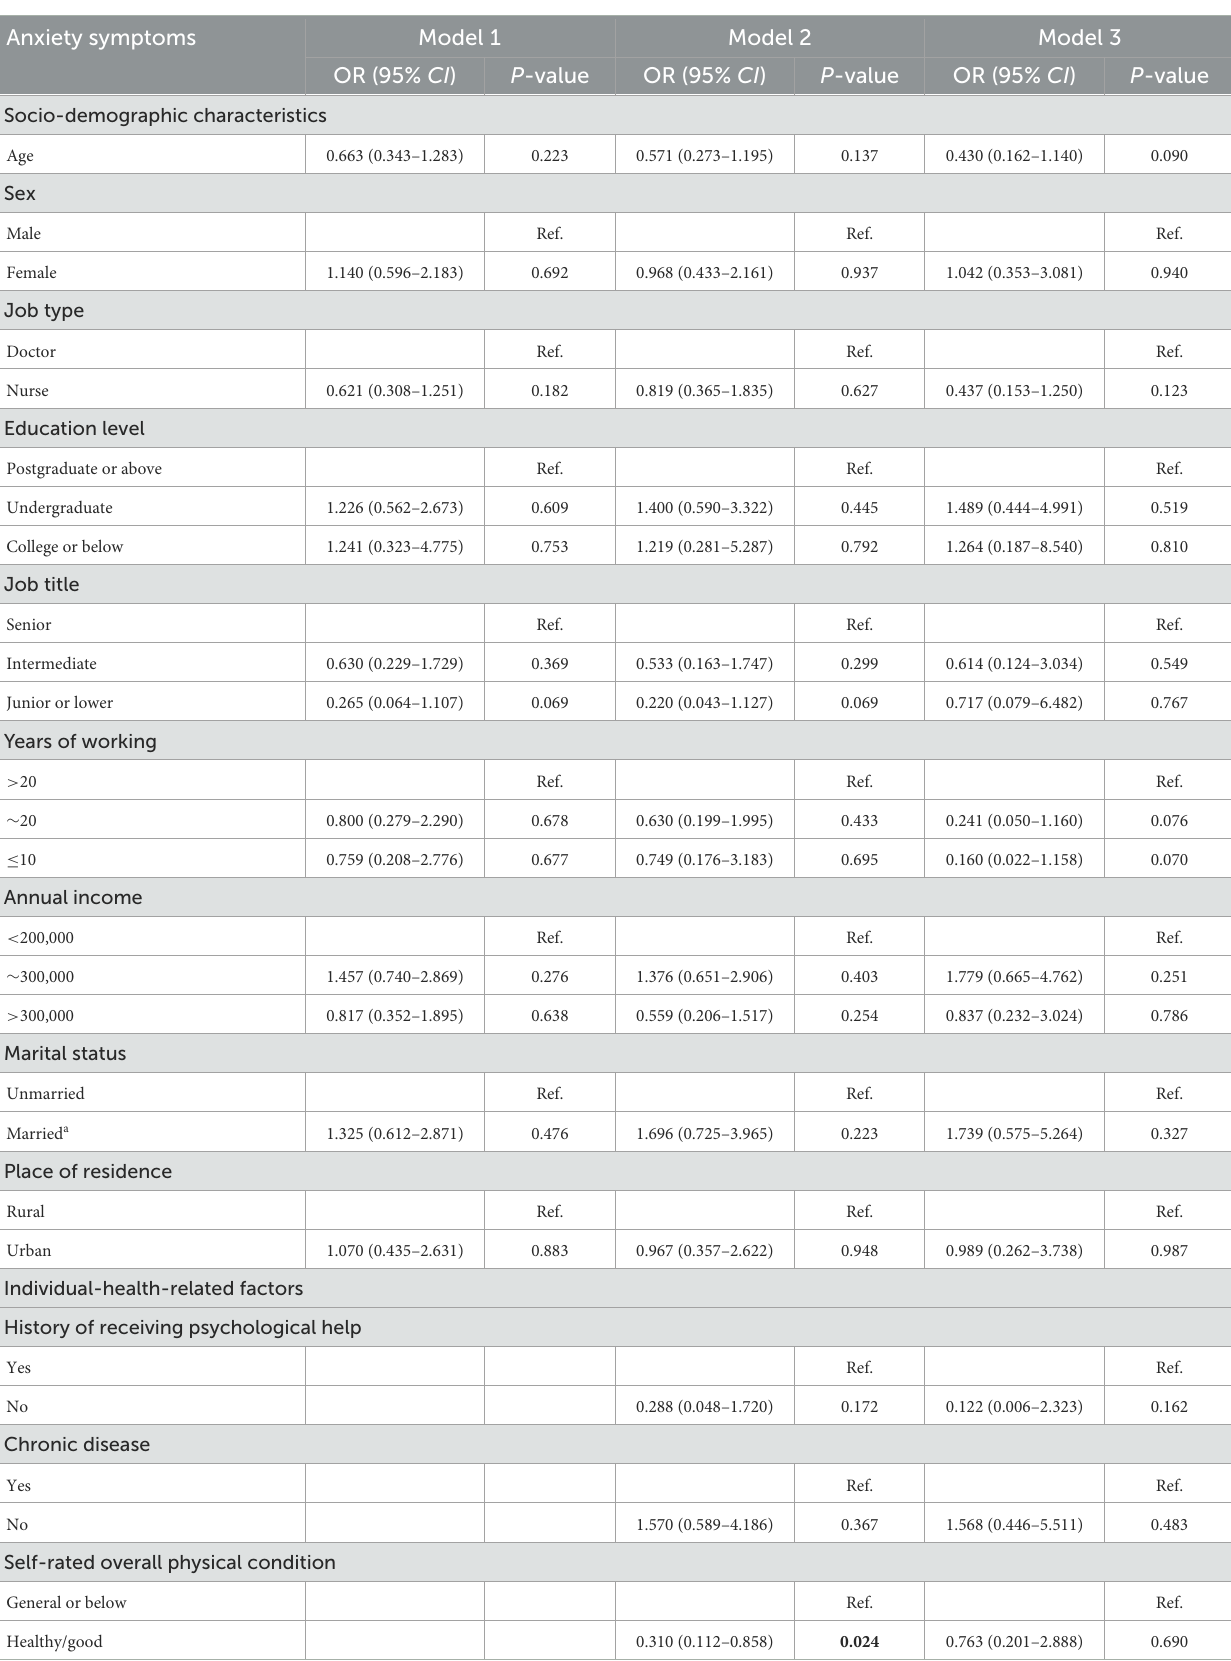
TABLE 3 Logistic regression analysis of anxiety symptoms in the